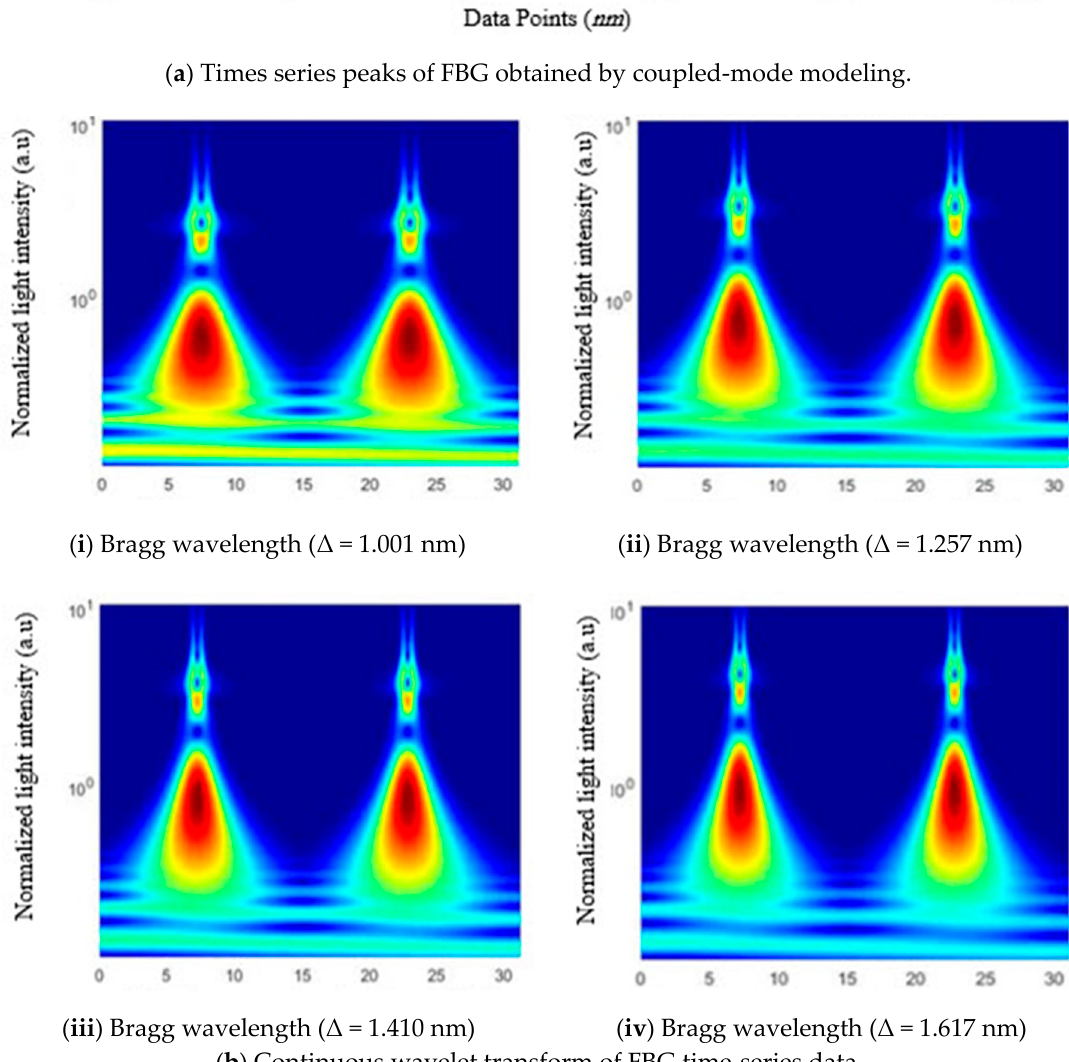
Figure 8. Theoretical optical-sensor time-series data obtained by coupled-mode modeling.